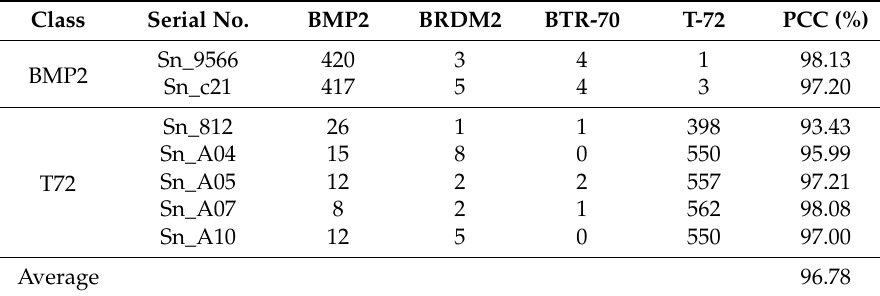
Table 8. Confusion matrix of the proposed method under configuration variance.